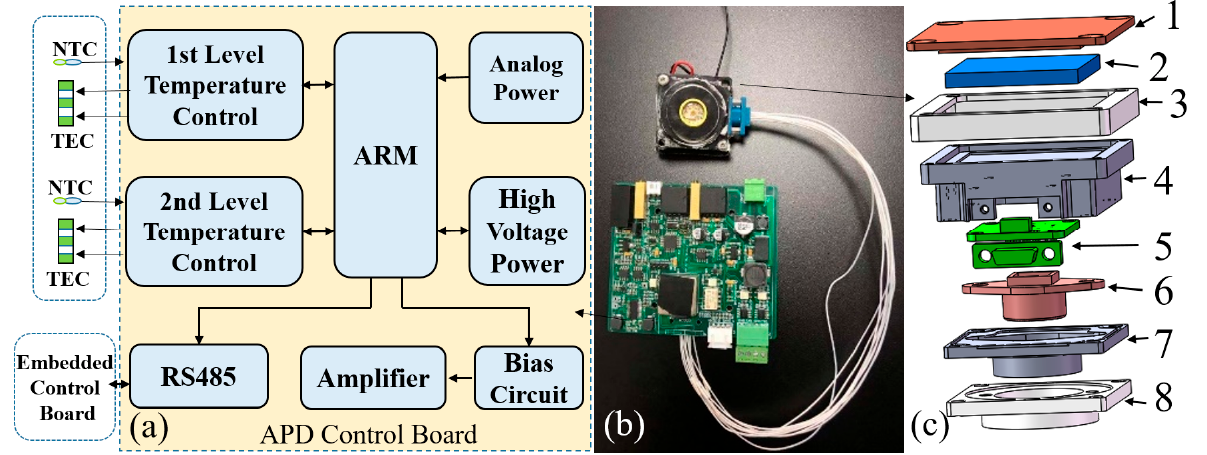
Figure 8. ( a ) Schematic diagram of APD control unit, ( b ) photo of APD detector and ( c ) internal structure diagram of APD: (1) Cu-heat sinks; (2) TEC; (3) nylon cover; (4) metal base; (5) PCB; (6) APD; (7) metal base; (8) nylon base.